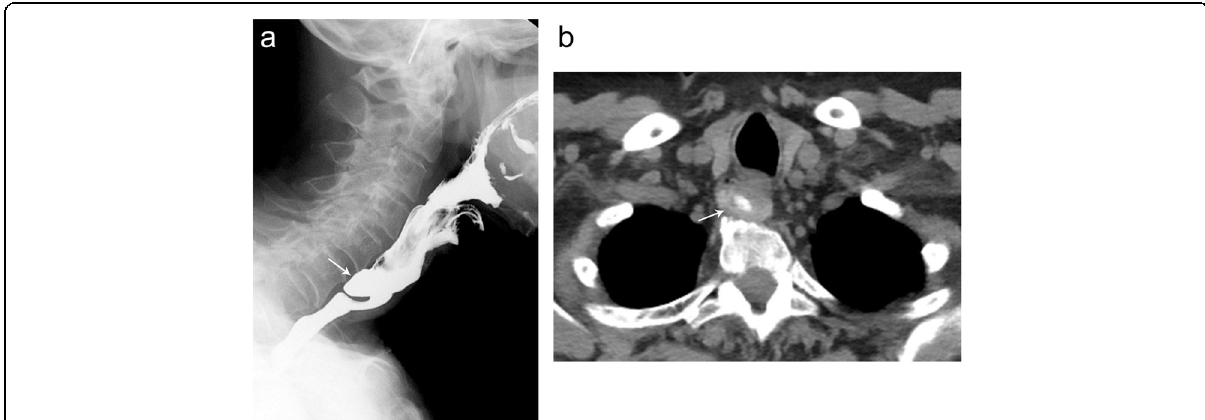
Fig. 13 Zenker diverticulum. Lateral ( a ) fluoroscopic images demonstrate a focal outpouching from the posterior aspect of the esophagus containing an air-contrast level consistent with a Zenker diverticulum. Axial ( b ) noncontrast CT images from the same patient demonstrate residual oral contrast (arrow) within the Zenker diverticulum arising from the posterolateral aspect of the